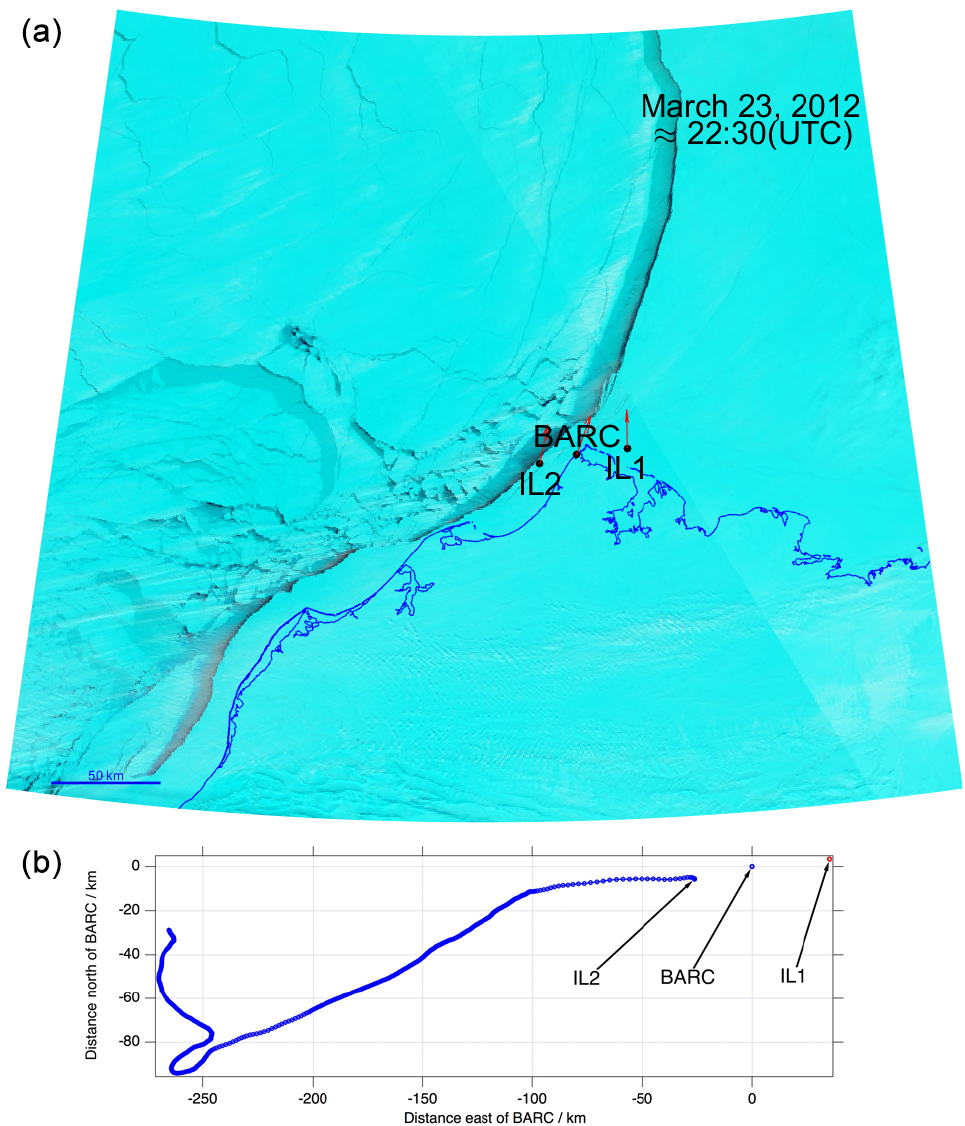
Figure 1. Panel (a) shows the locations of IL1, BARC, and IL2 instruments overlaid on the 23 March 2012 sea ice map from daily RGB composite 250m resolution MODIS images of ice conditions using bands 7, 2, and 1 (2105–2155, 841–876 and 620–670nm wavelengths, respectively) from the NASA Aqua satellite. In this composite, sea ice is light blue, open water is black, and clouds are white. The red arrows show the MAX-DOAS viewing direction, over which BrO was averaged. The wind was from the northeast (can be seen by thin “cloud streets”, which are wind-parallel horizontal convective rolls) and was pushing the lead open and causing IL2 to break away from shore-fast ice and drift westward. IL1 was the most upwind instrument, BARC in the middle, and IL2 downwind. Panel (b) shows the location of the two mobile platforms (IL1 and IL2) relative to BARC building during the drift phase. See Fig. 2 for drift distance versus